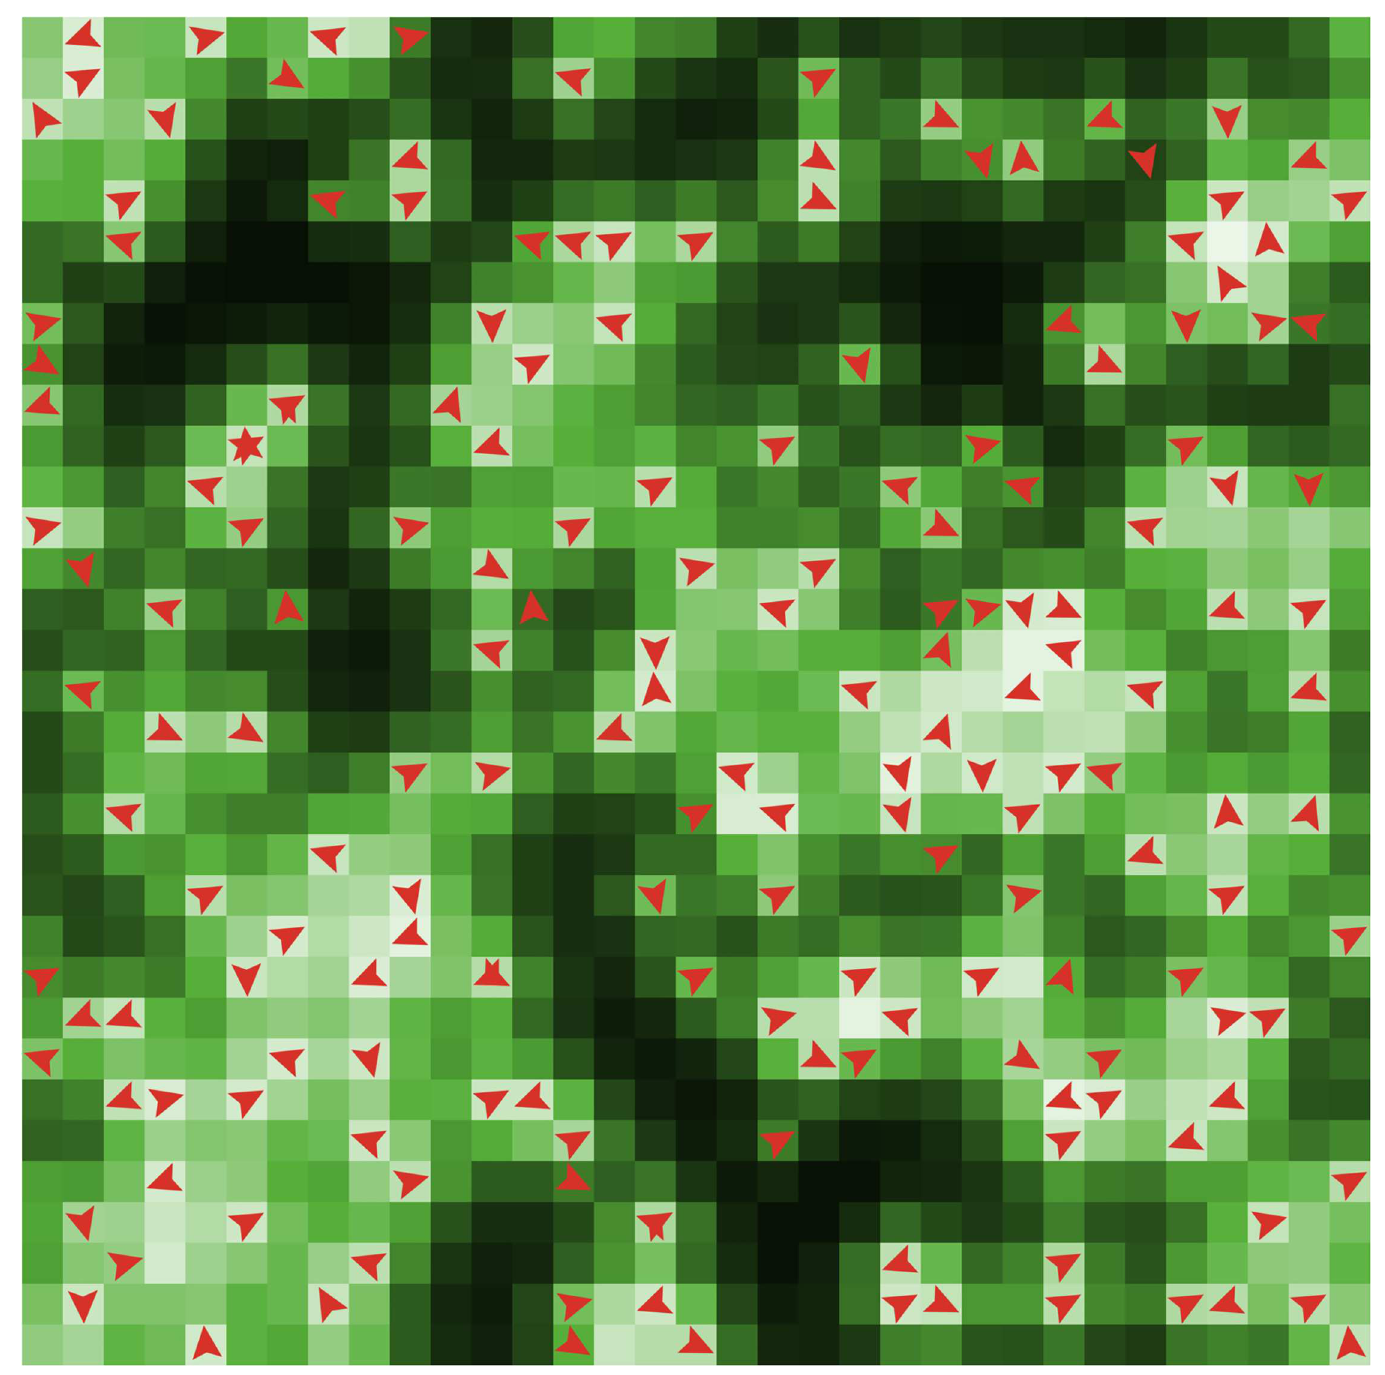
Fig 5. Snapshot of a typical simulation run of the ABM test-case. The ABM is composedof a squaregrid of sites. Dark coloursindicatesites with high resourcedensities,while light coloursindicate low densities.The red arrows show the current locationsof agents.